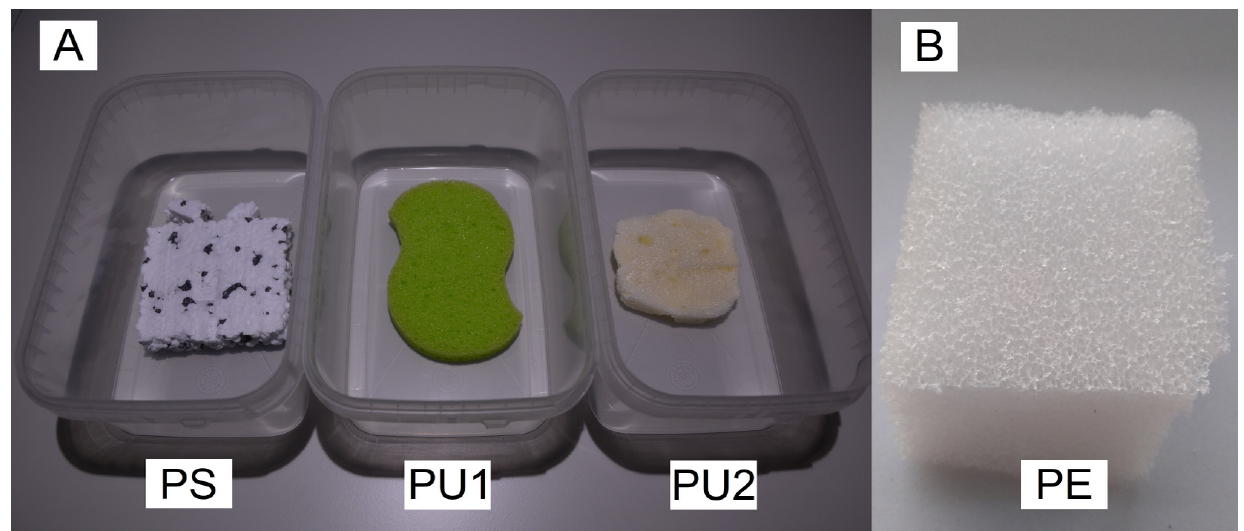
Figure 1. Plastics used for the experiment. ( A ) Materials for which time-lapse video was created. From left: polystyrene (PS), polyurethane kitchen sponge (PU1), polyurethane thermal insulation foam (PU2). ( B ) Polyethylene packaging foam (PE).